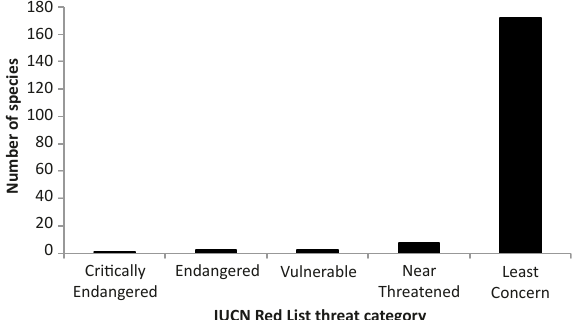
Figure 3. Number of bird species according to IUCN Red List threat categories in the Yamuna Nagar